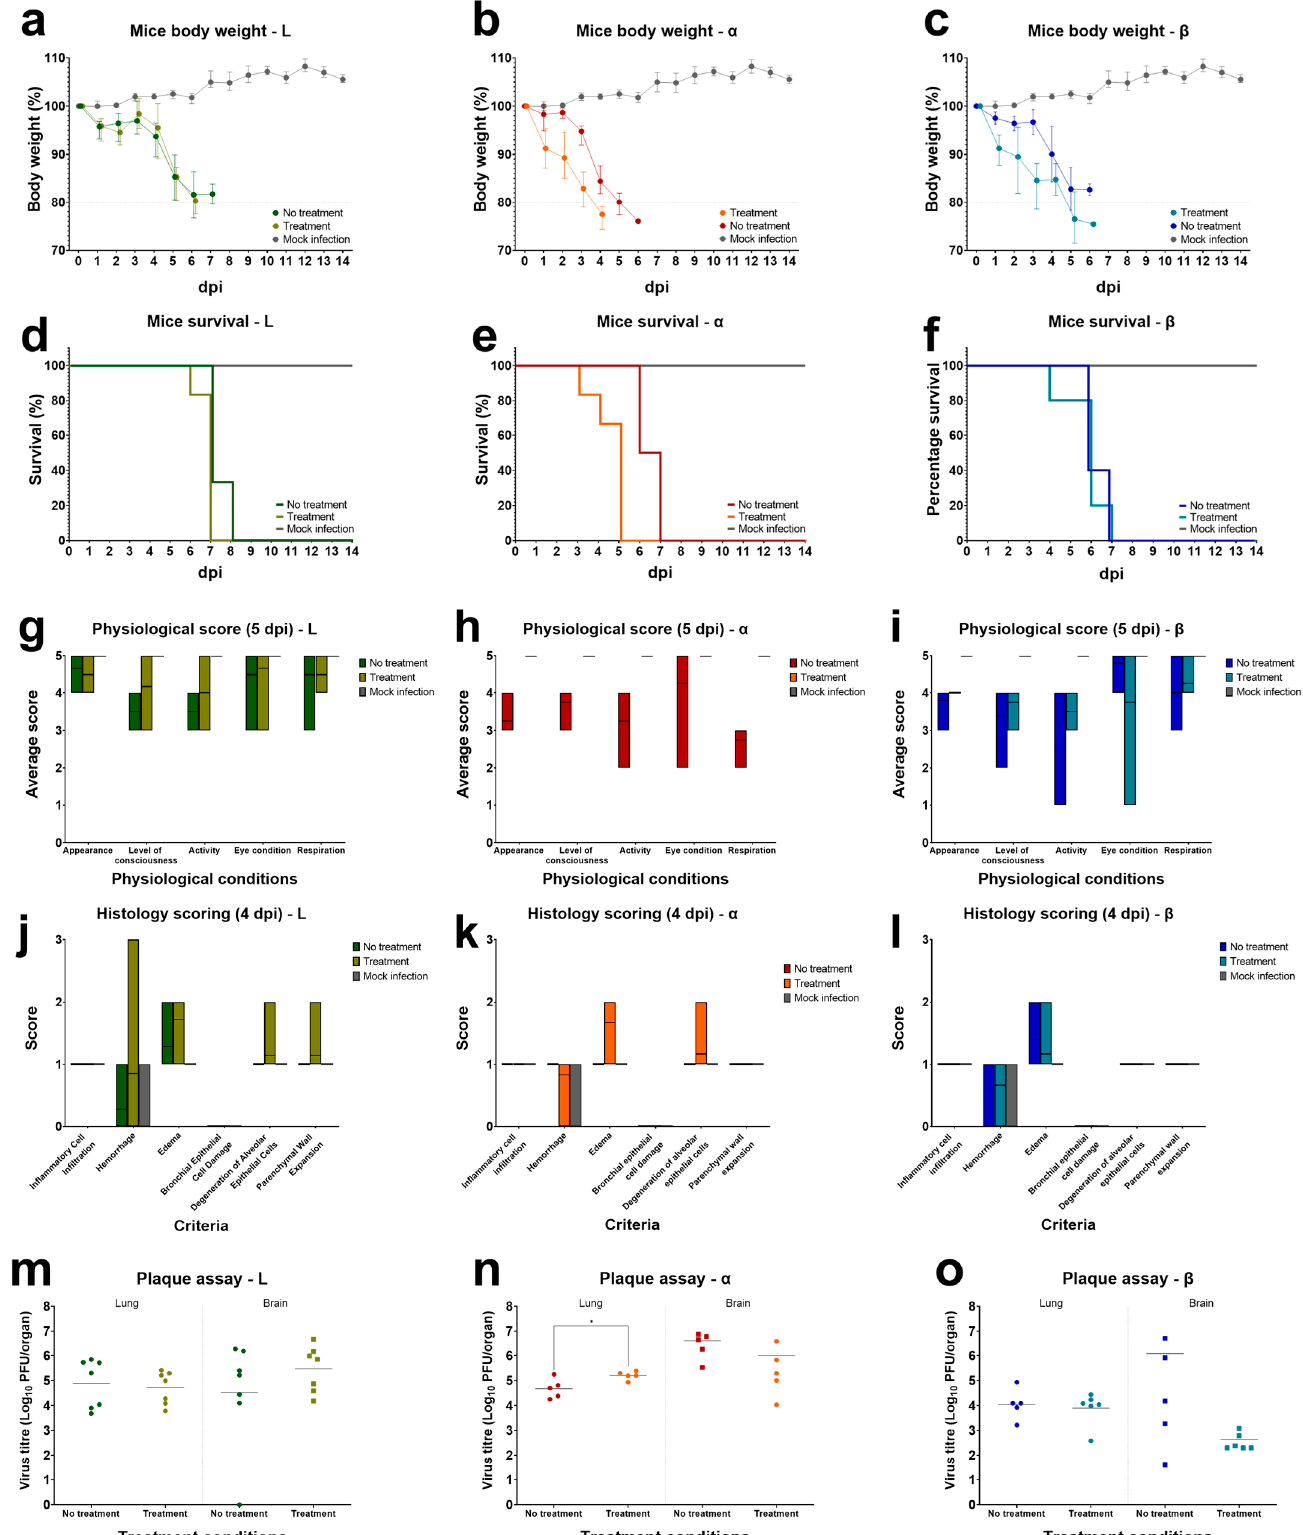
Figure 6. In vivo study of calcitriol treatment. 8-week old K18-hACE2 male and female mice were separated into treatment and non-treatment groups. Treatment study group has been given 3 days pre-treatment and 5 days post-treatment of calcitriol (5 μ g/kg) via intraperitoneal injection. The non-treatment group has been given a PBS as a treatment control. Next, 10 3 PFU of SARS-CoV-2 (L,